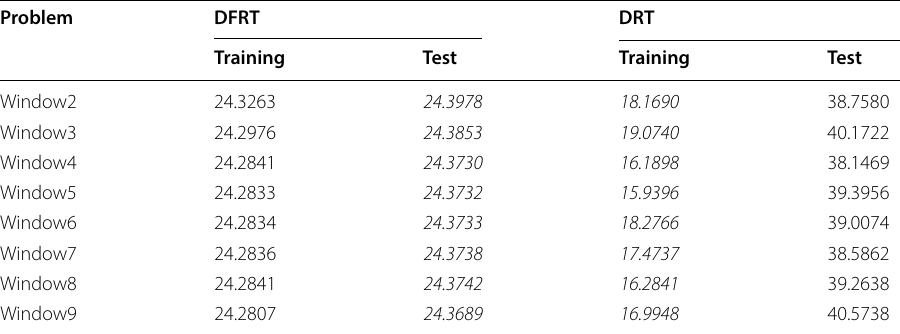
Table 3 Average MSEs obtained by DFRT and DRT on the training and test sets for the real- world problems